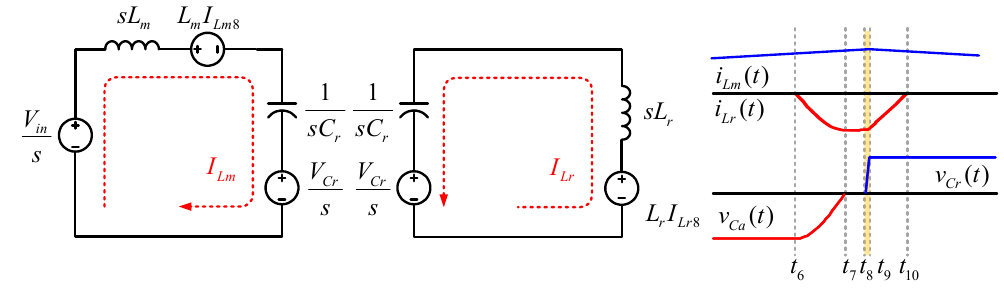
Figure 12. The equivalent circuit of Mode 9 and key waveform.